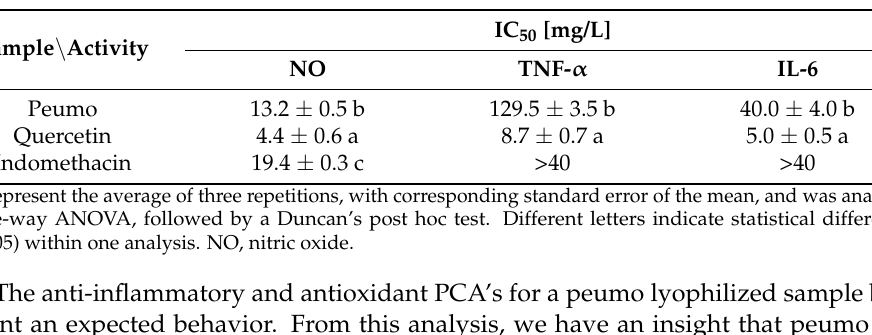
Table 5. The concentration of peumo halves the markers of inflammatory response. Data represent the average of three repetitions, with a corresponding standard error of the